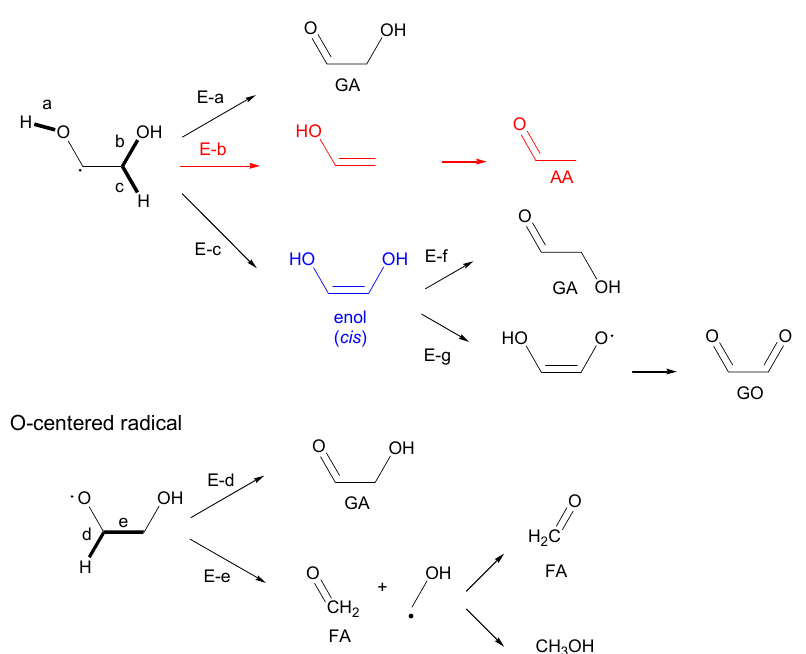
Figure 10. Possible radical chain pathways from the C- and O-centered radicals of ethylene glycol (EG). The bond with a bold line, which is located at the β -position to the radical, is expected to be cleaved through β -scission reaction. GA, glycolaldehyde; GO, glyoxal; AA, acetaldehyde; and FA, formaldehyde.